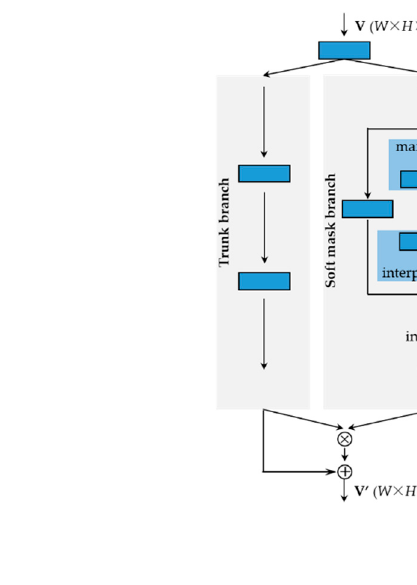
Figure 3. Structure illustration of the spatial, channel-wise attention, and the residual attention module. ( a ) Spatial and channel-wise attention; ( b ) residual attention (RA) module, where n denotes the number of units ( n ≥ 0), the dotted line is disconnected if n is 0 and 1, and is connected when n is larger than 1; the blue block is the residual block [35] with spatial or channel-wise attention.